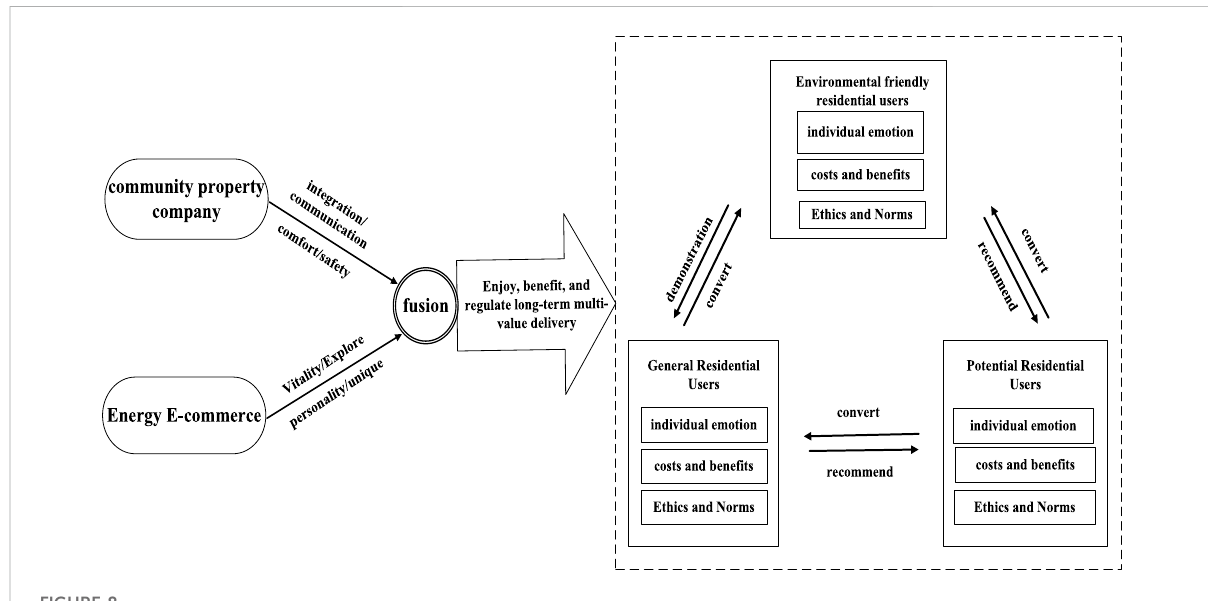
FIGURE 8 Residents ’ participation in the smart electricity value co-creation path analysis